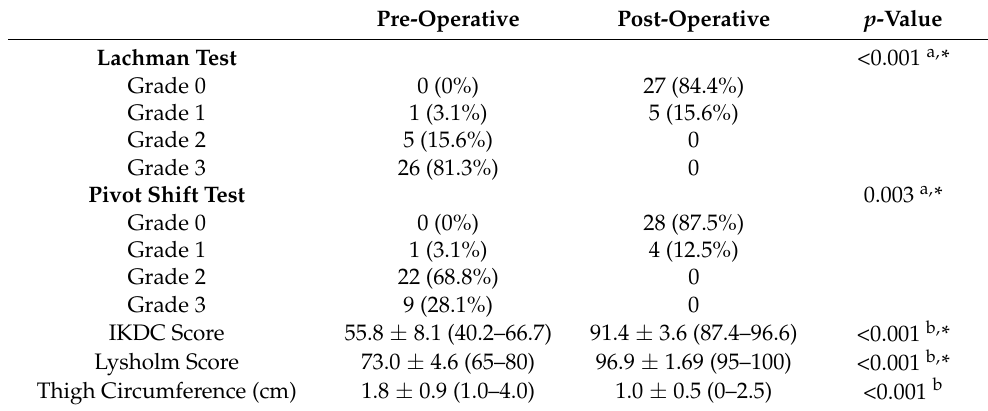
Table 2. Functional assessment of participants. Results are presented as numbers